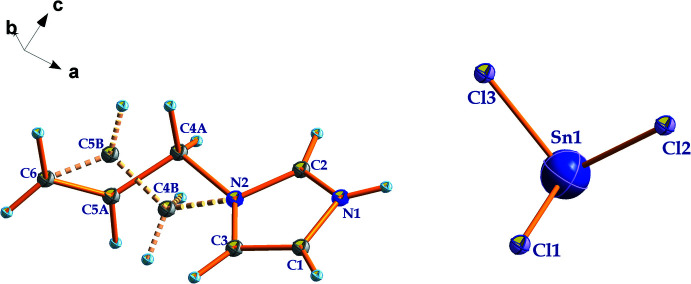
The asymmetric unit of (C6H9N2)2[SnCl6], showing the atom-labelling scheme and the disorder of the allyl group with occupancies of 0.512 (9) (solid bonds) and 0.488 (9) (broken bonds).